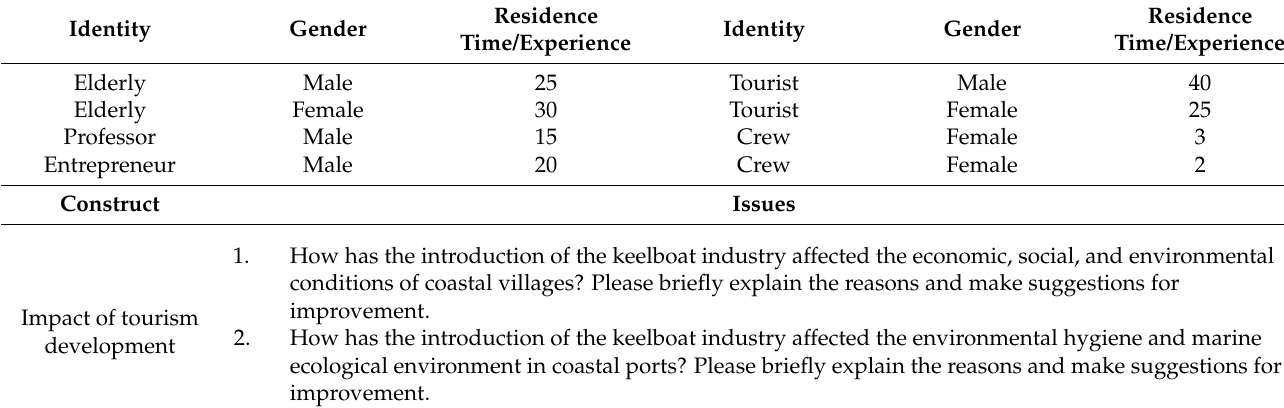
Table 3. Respondent’s background information and an overview of the interview